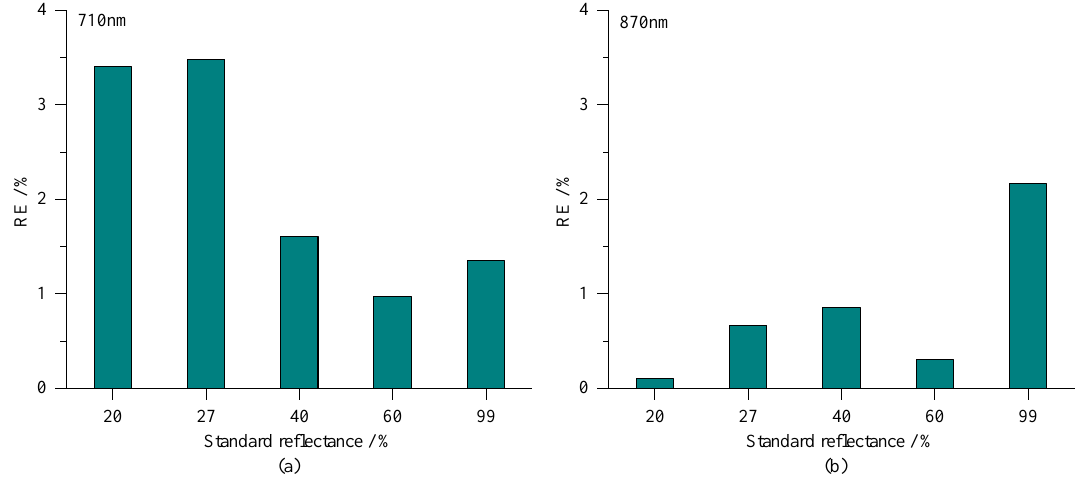
Figure 13. Relative error of the reflectance measured by the sensor. ( a ) 710 nm; ( b ) 870 nm.